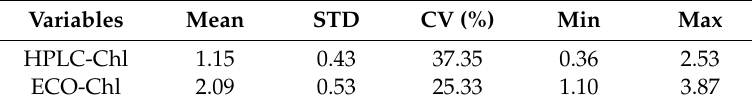
Table 1. Statistics and comparisons of HPLC-Chl and ECO-Chl.